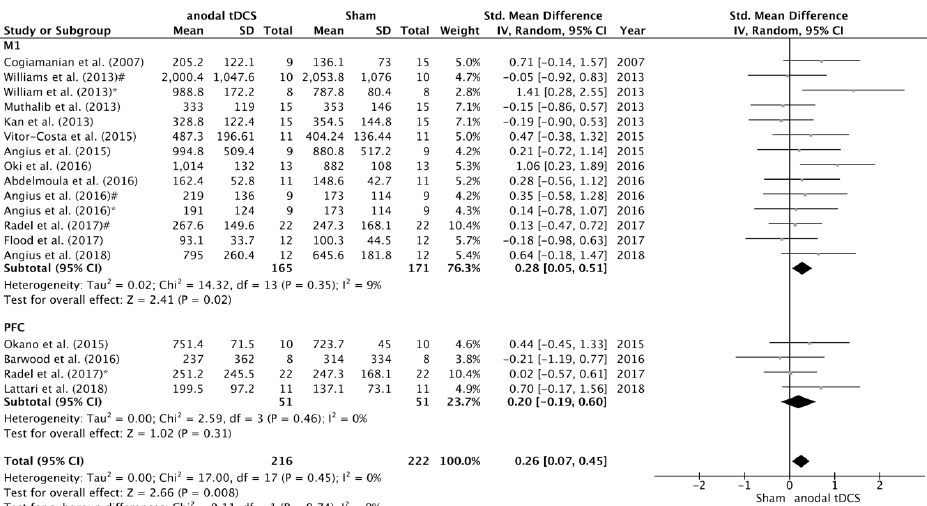
Figure 4. Forest plot of the subgroup analysis for the comparison of the TTF between anodal tDCS over M1 versus PFC. Williams et al. [17] *—subgroup that received full time anodal tDCS during the task (i.e., submaximal isometric elbow contraction until failure). Williams et al. [17] #—subgroup that received part time anodal tDCS during the task (i.e., submaximal isometric elbow contraction until failure). Angius et al. [27] *—condition in which the subjects received anodal tDCS using a cephalic montage (Anode in M1 and Cathode in right DLPFC). Angius et al. [27] #—condition in which the subjects received anodal tDCS using an extracephalic montage (Anode in M1 and Cathode in shoulder). Radel et al. [16] *—condition in which the subjects received anodal tDCS over the PFC. Radel et al. [16] #—condition in which the subjects received anodal tDCS over the PFC. Regarding duration of stimulation, the studies in which the stimulation time was > 10 min the change in time to task failure after the intervention changed in favour the anodal versus sham condition (SMD = 0.43; 95% CI = 0.04, 0.81; P = 0.03). There were no statistical differences on the SMD between anodal and sham conditions when the stimulation time was ≤ 10 min (SMD = 0.17; 95% CI = −0.07, 0.41; P = 0.17) (Figure 5).